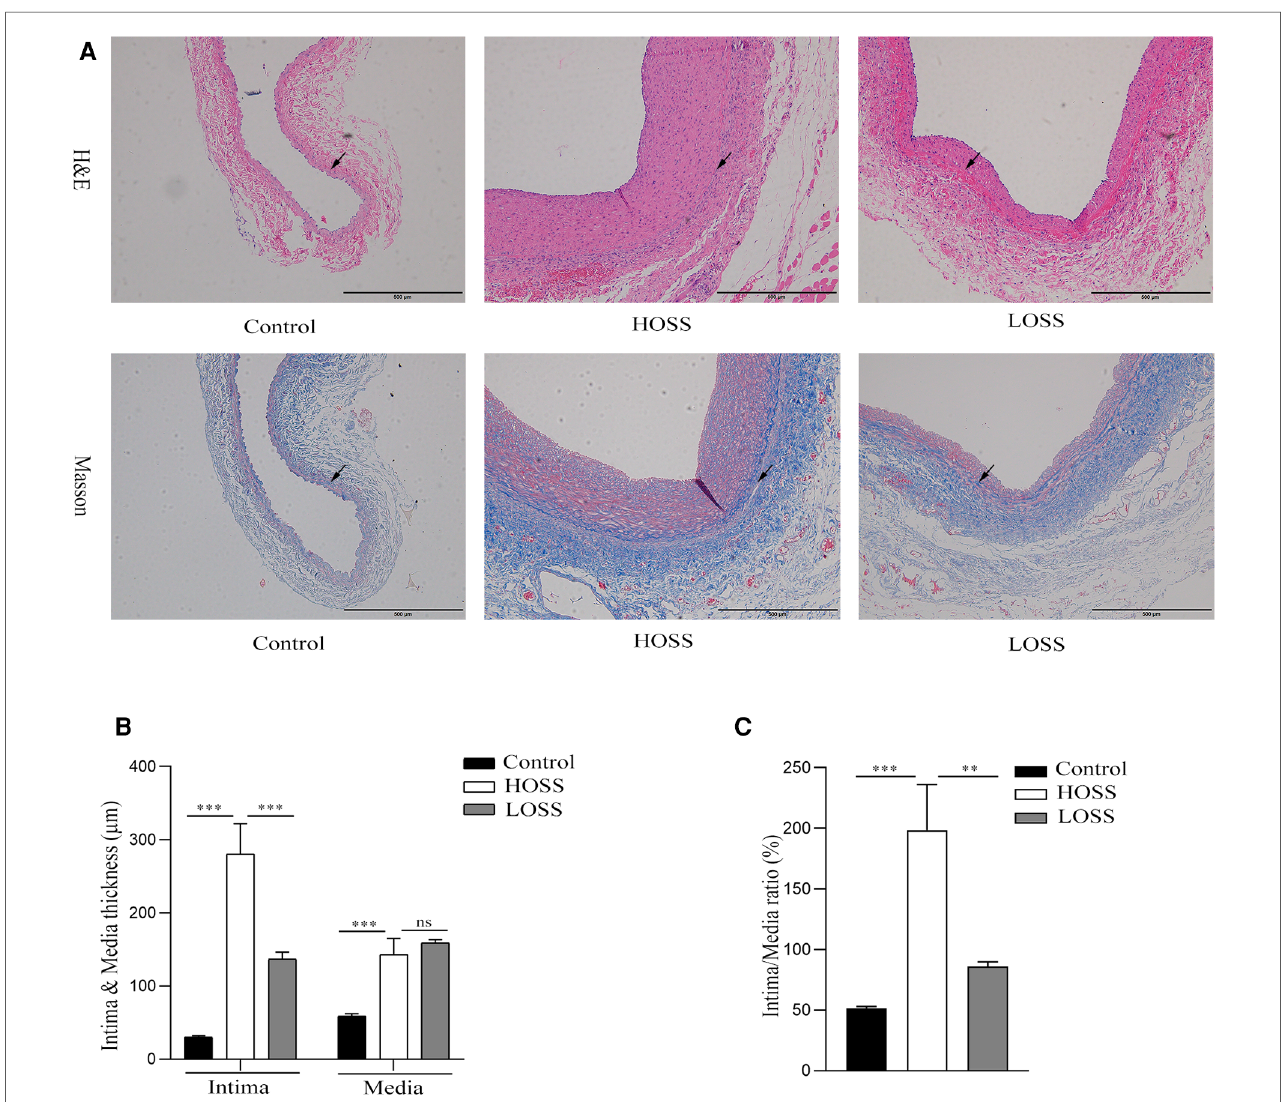
FIGURE 3 The extent of graft vein proliferation and structural changes. ( A,B ) Hematoxylin and Eosin (H&E) staining and Masson ’ s Trichrome staining (magni fi cation,×100). ( C,D ) Changes in intima and media thickness and intima/media ratio in the three groups. Visible deposition of collagen fi bers (blue) in the graft vein to the media and muscle fi bers (red) to the endothelium in Masson stain. Oscillatory shear stress (OSS) promoted vascular proliferation and accelerated graft vein remodeling. Experiments were repeated in triplicate. ** P <0.01; *** P <0.001; ns: no signi fi cant difference. Black arrow: boundary between intima and